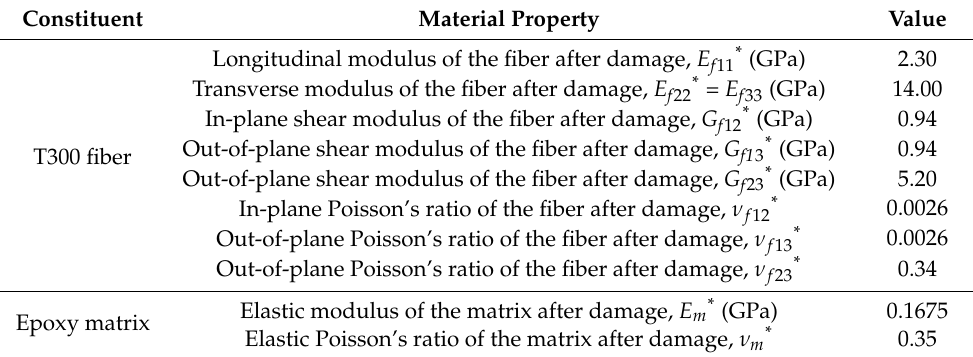
Table 12. Mechanical properties of the fiber and matrix constituents in the T300/Epoxy composite after the initiation of the microscale